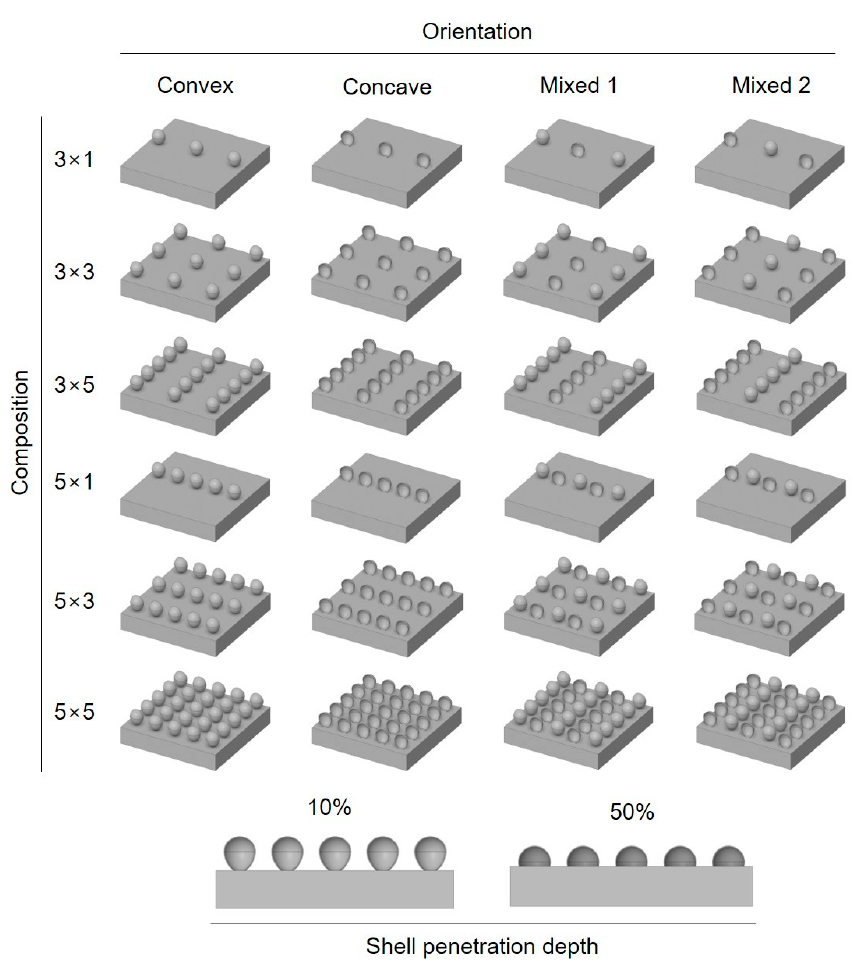
Figure 2. Schematic diagrams of the initial artificial oyster reef (AOR) model (not to scale). Table 1. The initial arti fi cial oyster reef (AOR) model. A total of 48 initial AOR models were con- structed by considering four shell orientations, six compositions, and two shell penetration depths.